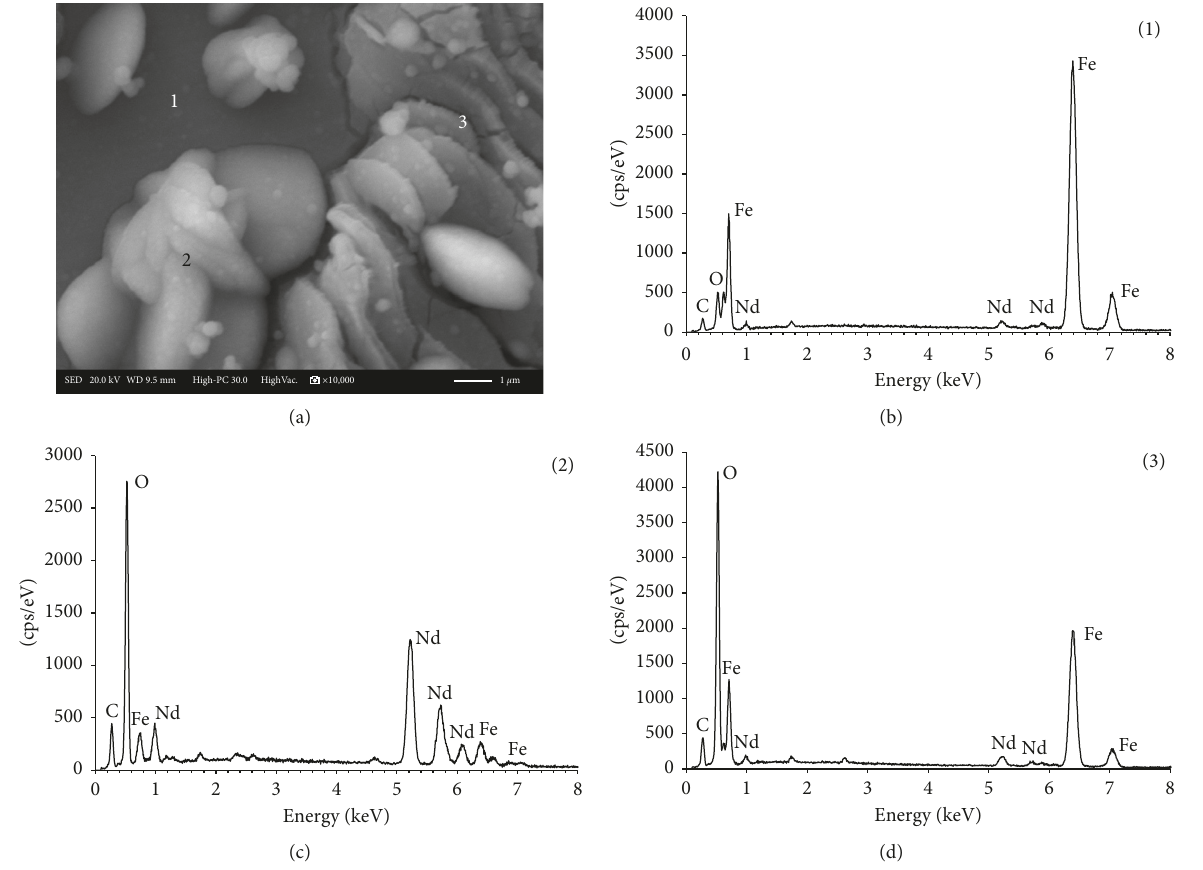
Figure 13: Elemental EDS analysis to the different morphologies observed on the API X70 steel